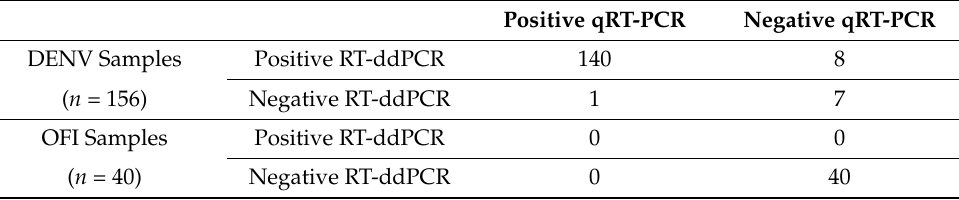
Table 1. DENV detection results of qRT-ddPCT and qRT-PCR with clinical samples. Positive qRT-PCR Negative qRT-PCR DENV Samples Positive